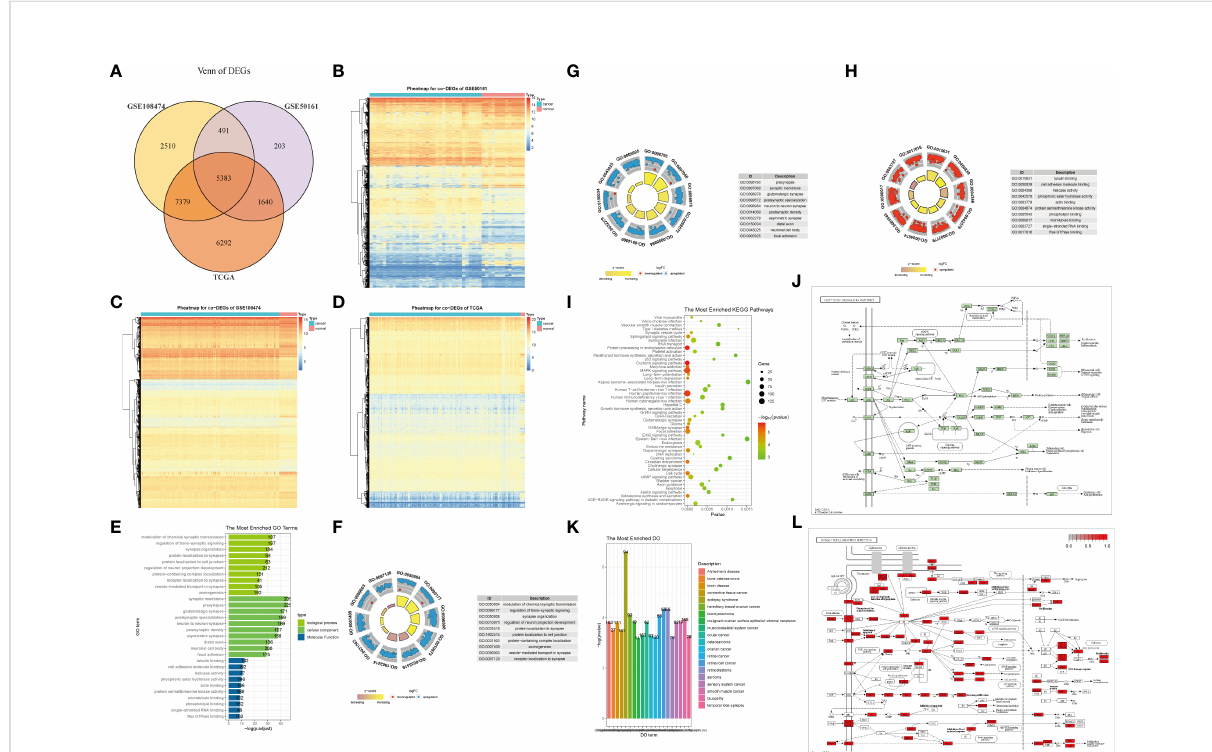
FIGURE 1 Differentially expressed genes(DEGs) and enrichment analysis in glioma. (A) Screening of the intersection of DEGs in the three datasets yielded 5,383 DEGs shared between the three datasets. (B – D) DEGs can distinguish tumor tissues from normal tissues in each grouping, which has signi fi cant representativeness. (E – H) GO function enrichment analysis on DEGs and enrichment of BP, CC, MF. (I, J, L) KEGG pathway enrichment analysis. (K) GO enrichment